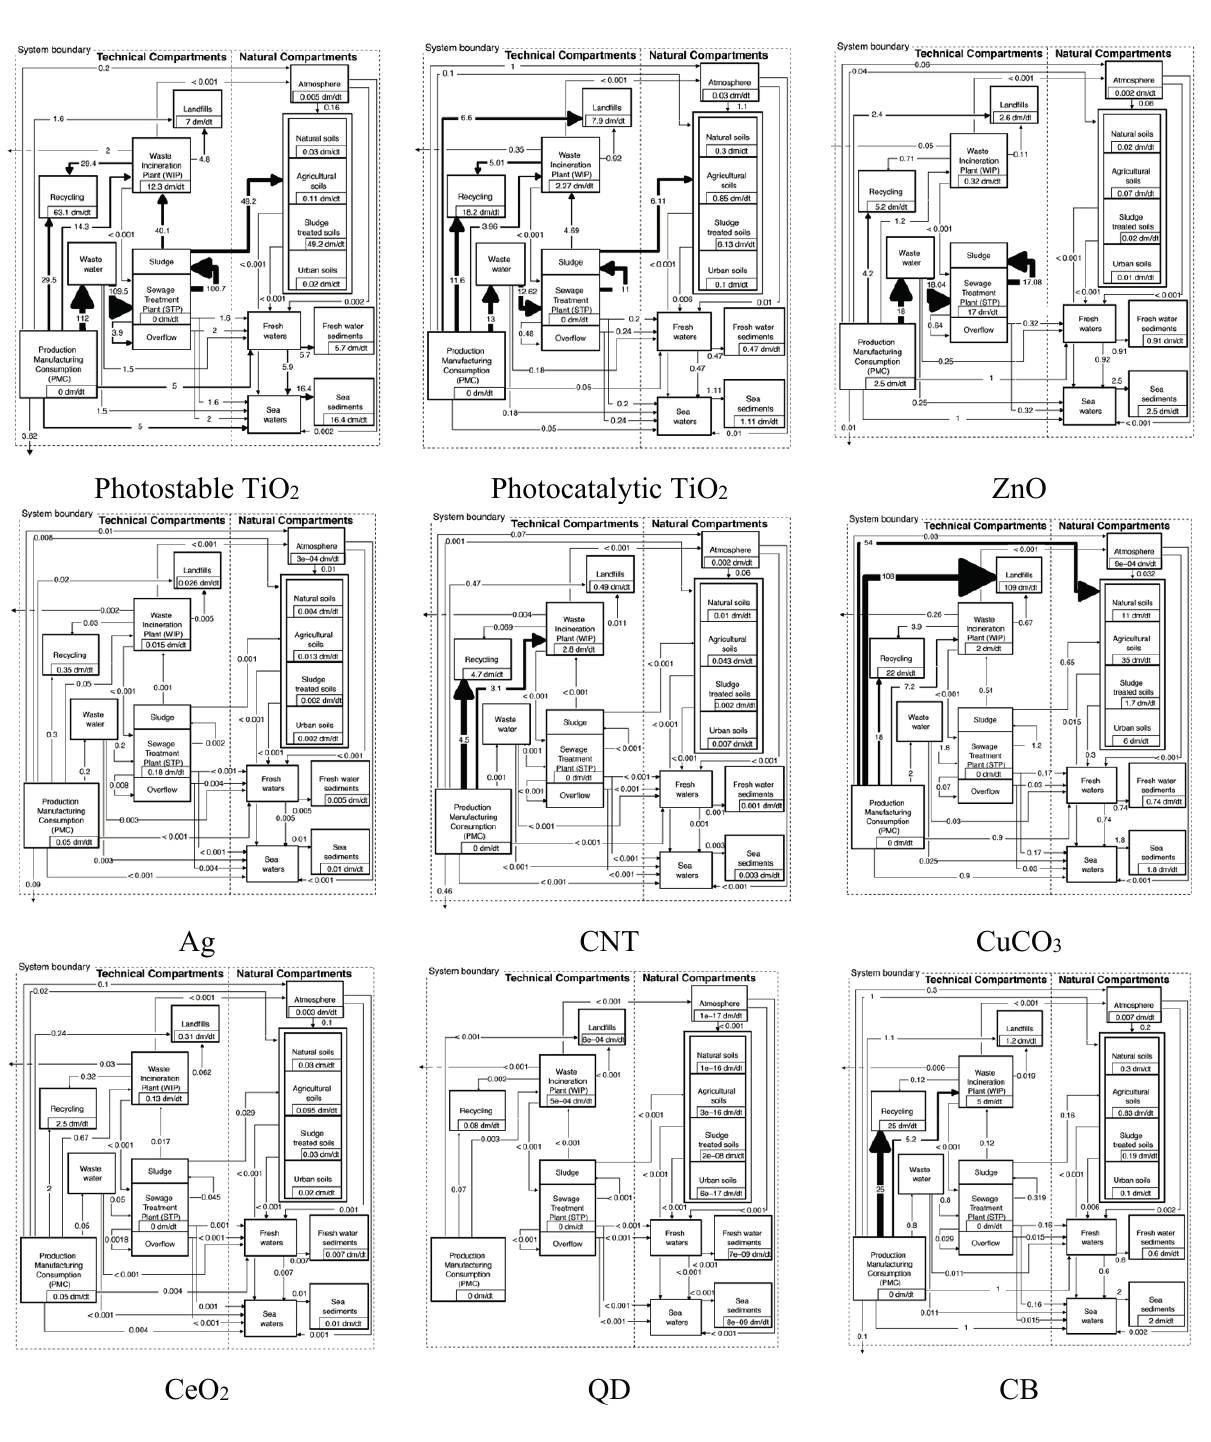
Figure 2. Mass flow diagrams for nine nanomaterials in Denmark. Rounded modal values are shown in tons/year (except CB where the unit is kt/y). Boxes show accumulation or transformation. The modes, combining all the Monte Carlo simulations show what has to be most likely expected at each place of the figure without necessarily reflecting in detail and holistically mass balance of the flow system. CNT: Carbon nanotubes; QD: Quantum dots; CB: Carbon